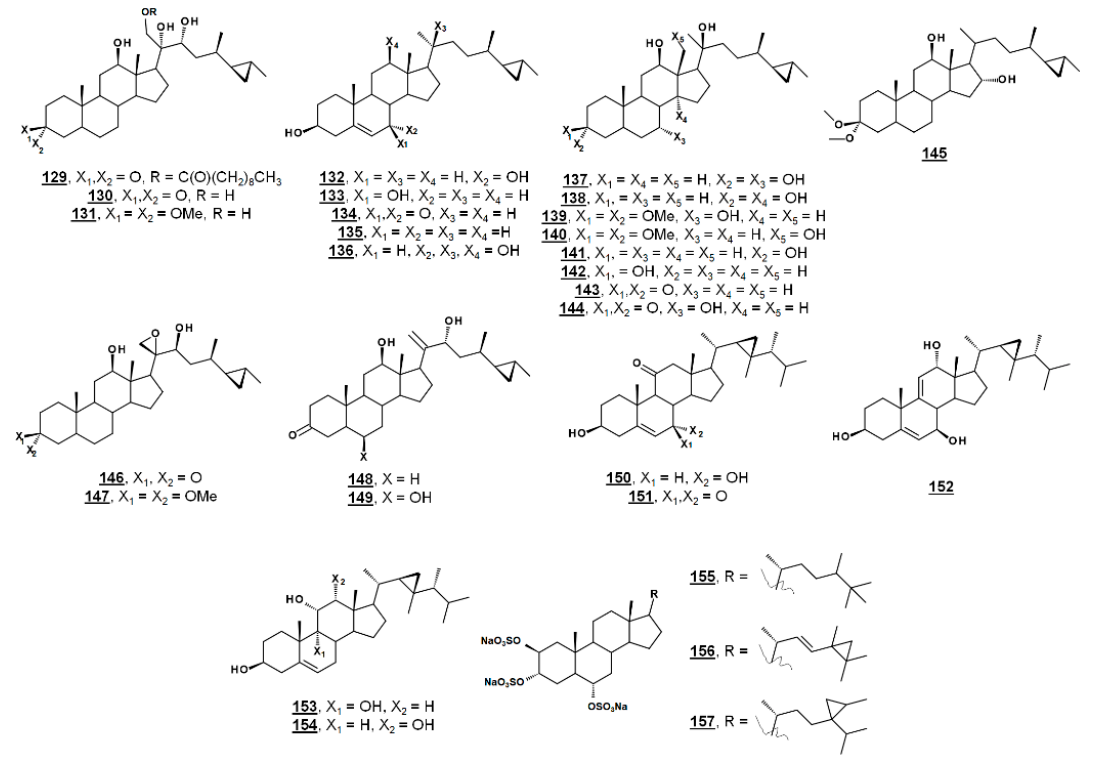
Figure 15. Sterols bearing a 3-membered ring.